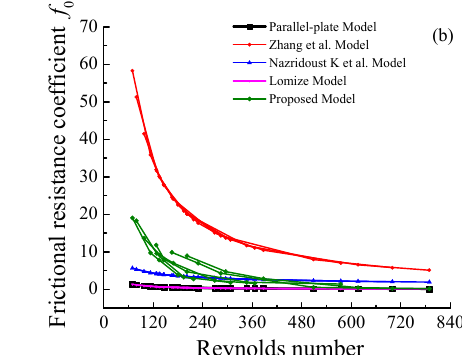
(b) Parallel-plate Model